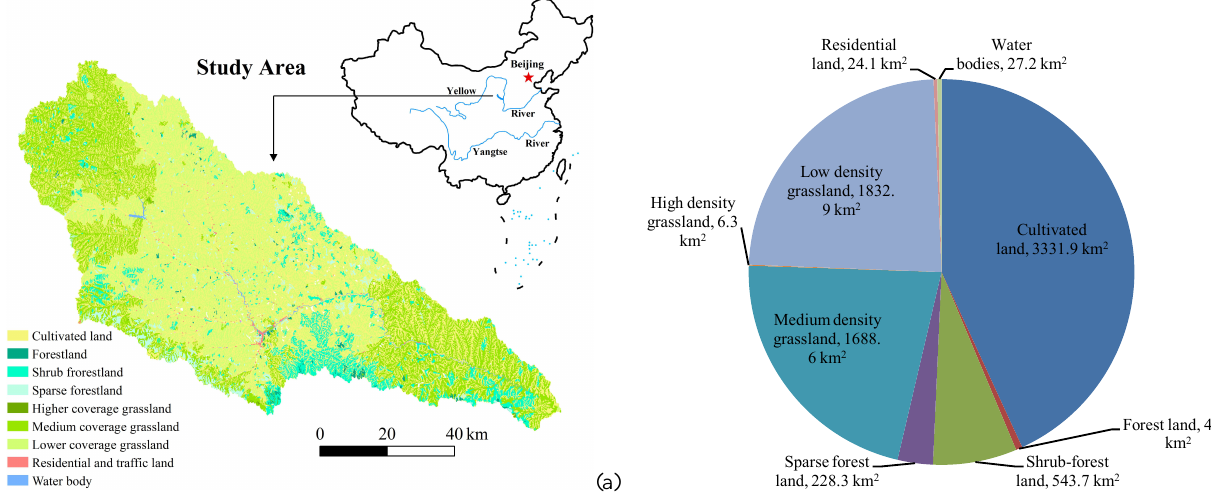
Fig. 1. (a) The location and land use of the study area. (b) Land use compositions of Yanhe